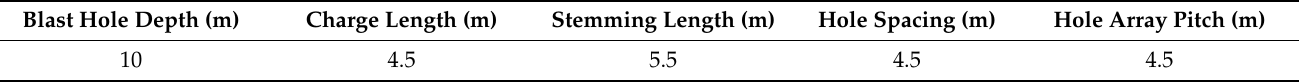
Table 2. Blasting